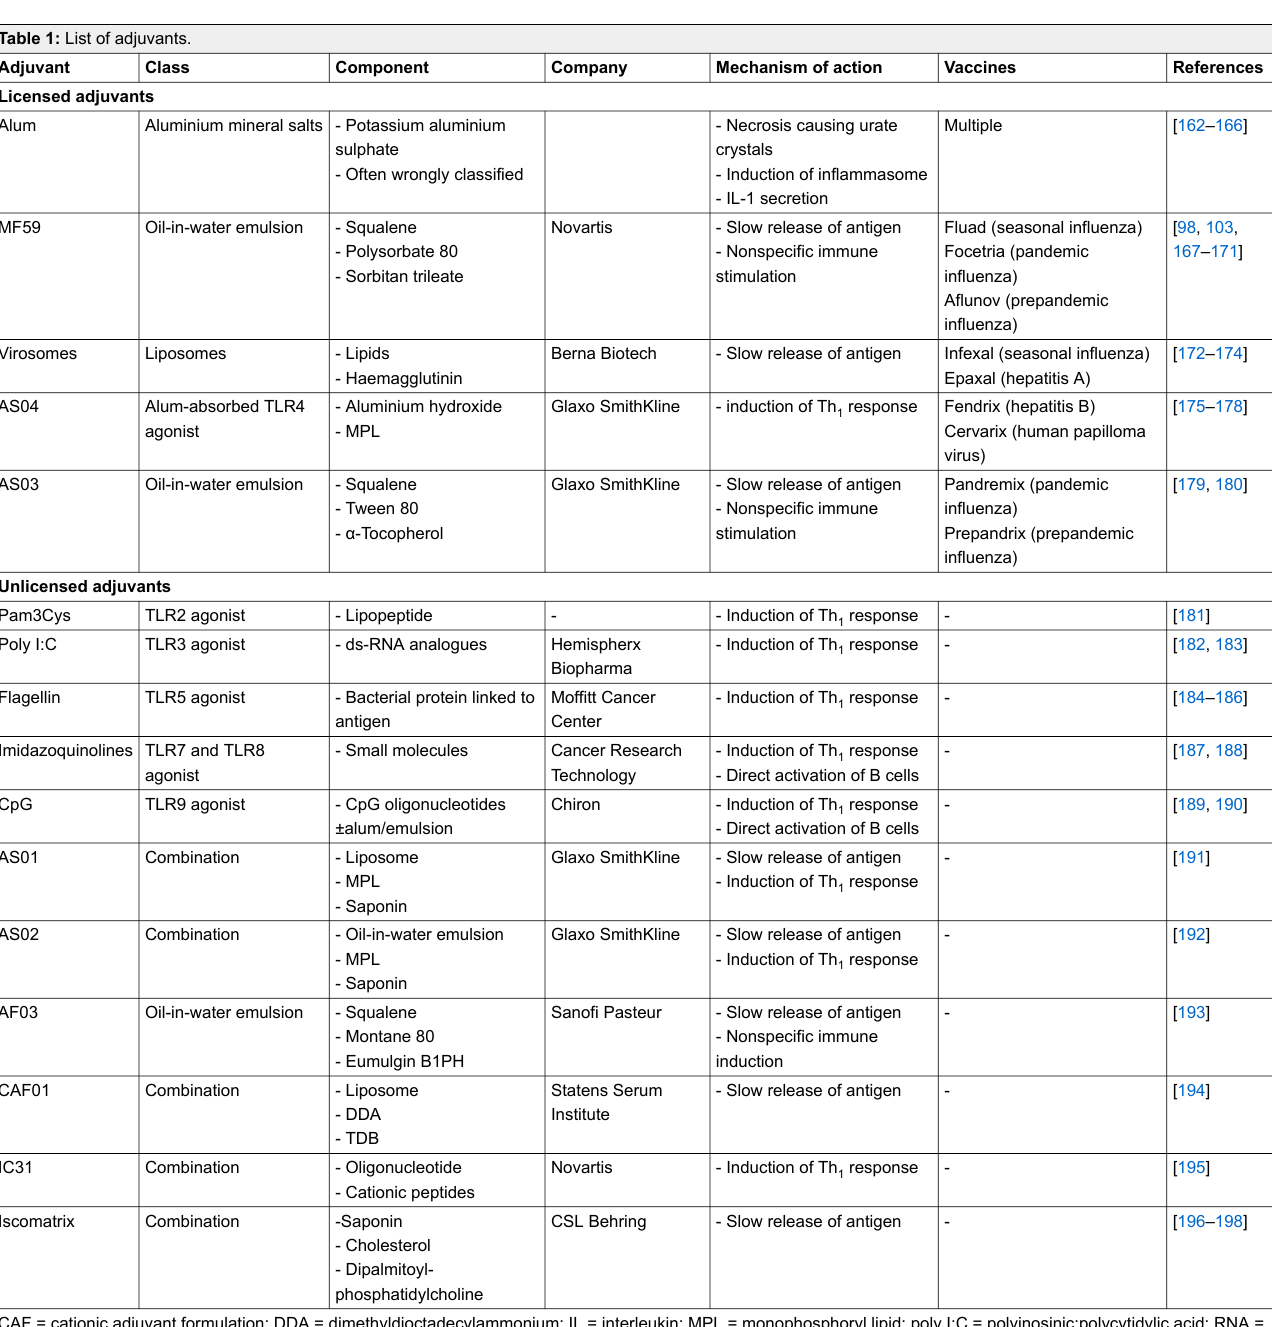
Table 1: List of